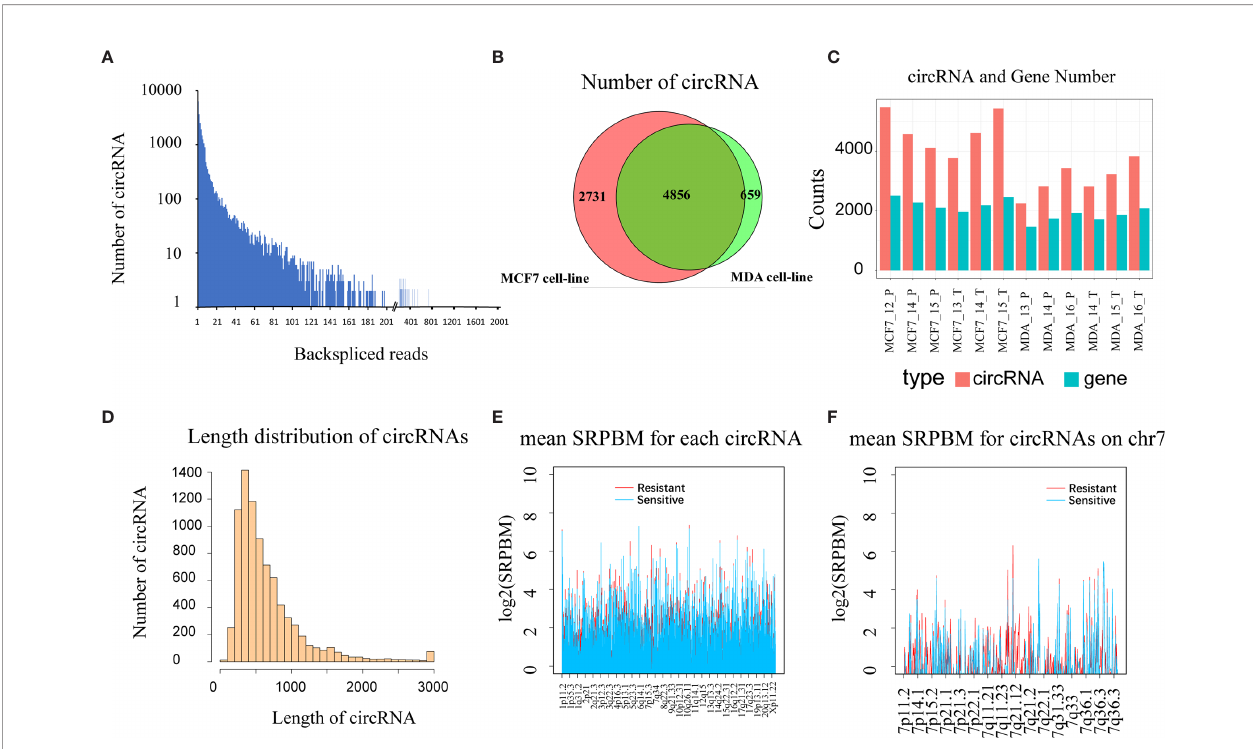
FIGURE 1 | Overview of circular RNAs detected in 12 breast cancer cell samples (three biological replicates for each of the MCF-7, MCF7-RES, MDA-MB-231 and MDA-RES cell lines). (A) The back-spliced reads and the number of circRNAs identi fi ed in 12 breast cancer cells. (B) The intersection of circRNAs detected in 6 MDA cells and 6 MCF cells. (C) The number of circRNAs and the number of circRNA genes in each sample. (D) The histogram shows the distribution of all detected circRNA lengths. (E) The expression level of circRNAs (SRPBM) in different groups throughout the genome. The docetaxel-resistant group is shown in red and docetaxel-sensitive group in blue. (F) Expression of circRNAs (SRPBM) in different groups across Chromosome 7. The resistant group is shown in red and the sensitive group in